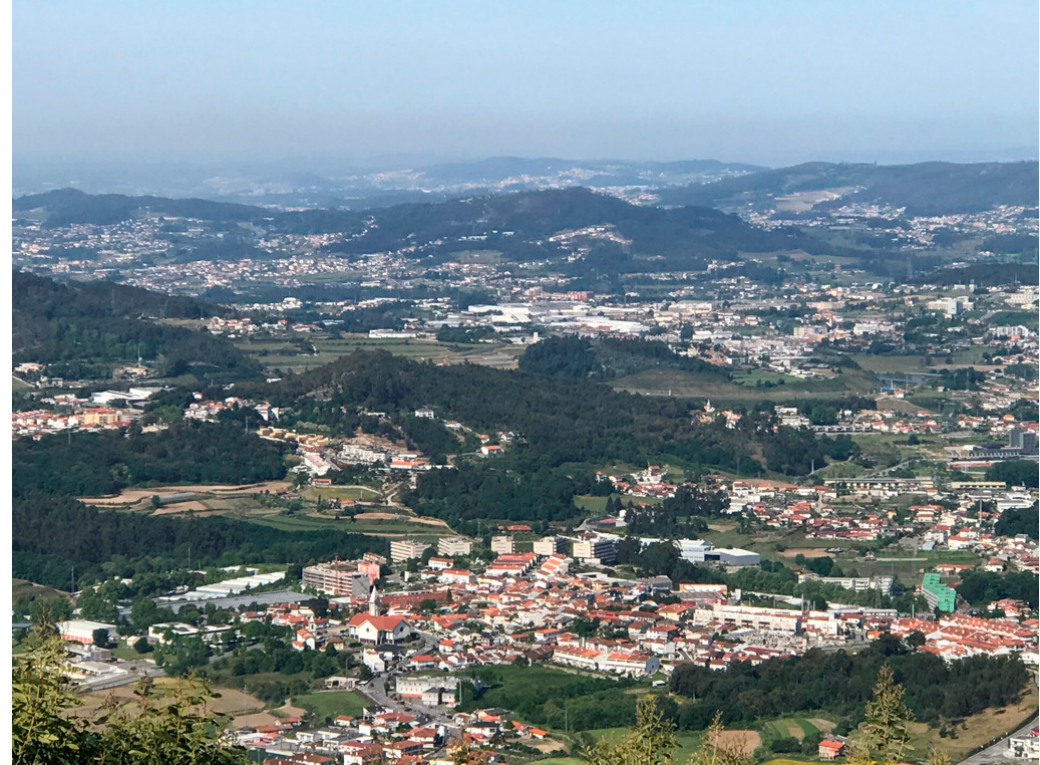
Figure 5. An example of part of the municipality of Guimarães where urban areas surrounded by forest and agriculture areas can be seen.